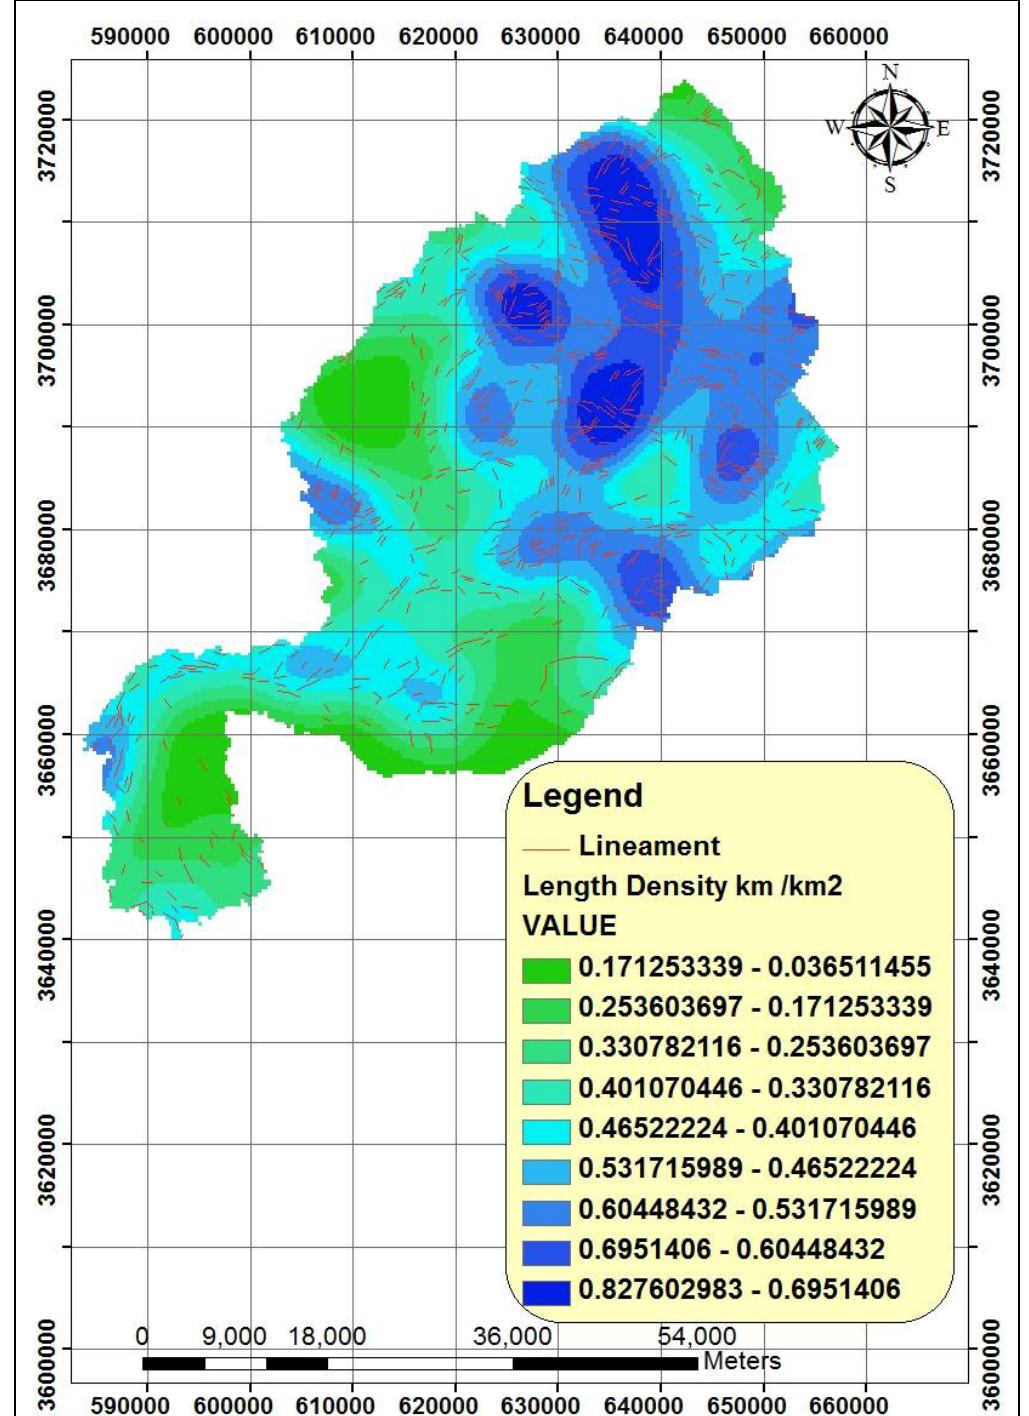
Fig. 6: The lineaments length density Map by using Arc